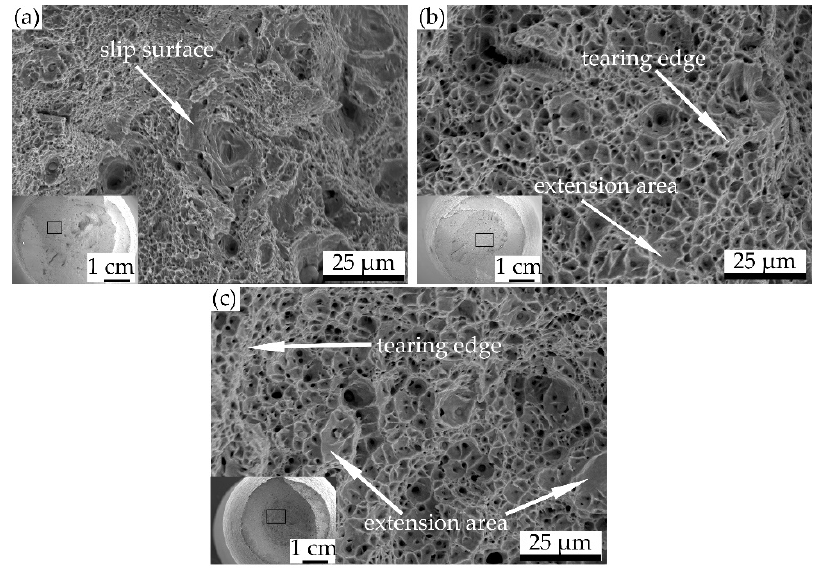
Figure 9. Tensile fracture morphology under different repair welding times. ( a ) Original casting; ( b ) once repair welded joint; ( c ) twice repair welded joint.